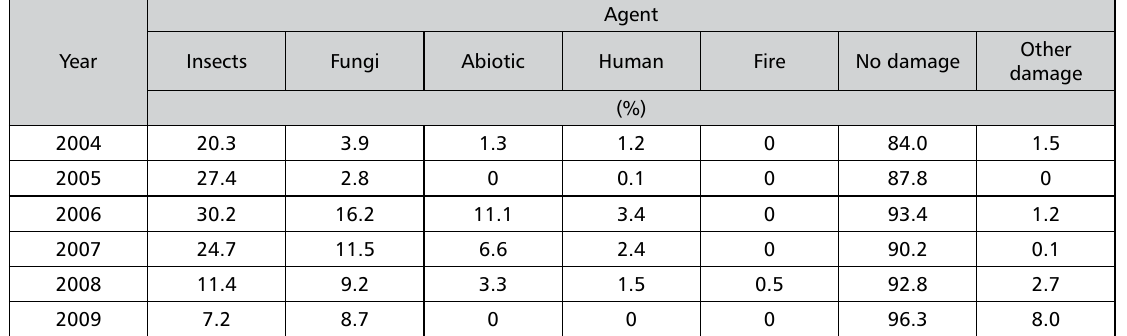
Causes of damage on beech trees in Serbia in the period 2004-2009